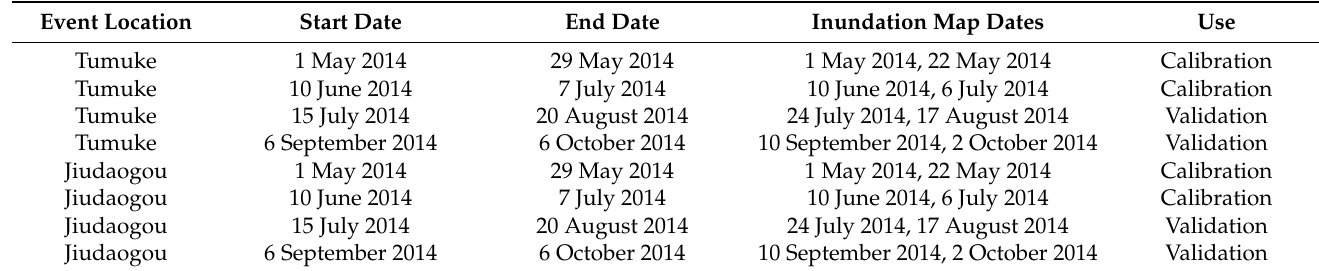
Table 2. Historical flooding events used for MIKE 21 hydrodynamic model calibration.